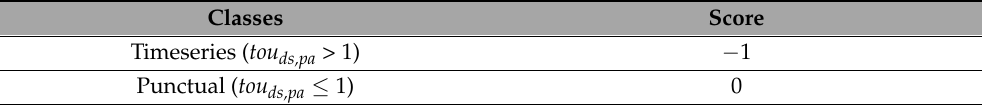
Table 12. TOU ds,pa —temporal overlap utility. Classes Score Timeseries ( tou ds,pa > 1) − 1 Punctual ( tou ds,pa ≤ 1) 0